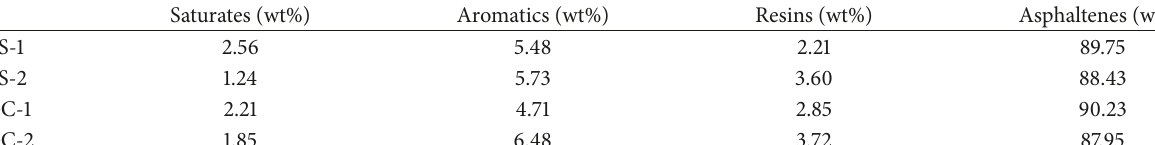
Table 2: The group components of the internal materials in the concretions. The sample numbers were same as those in Table 1 and Figure 4.